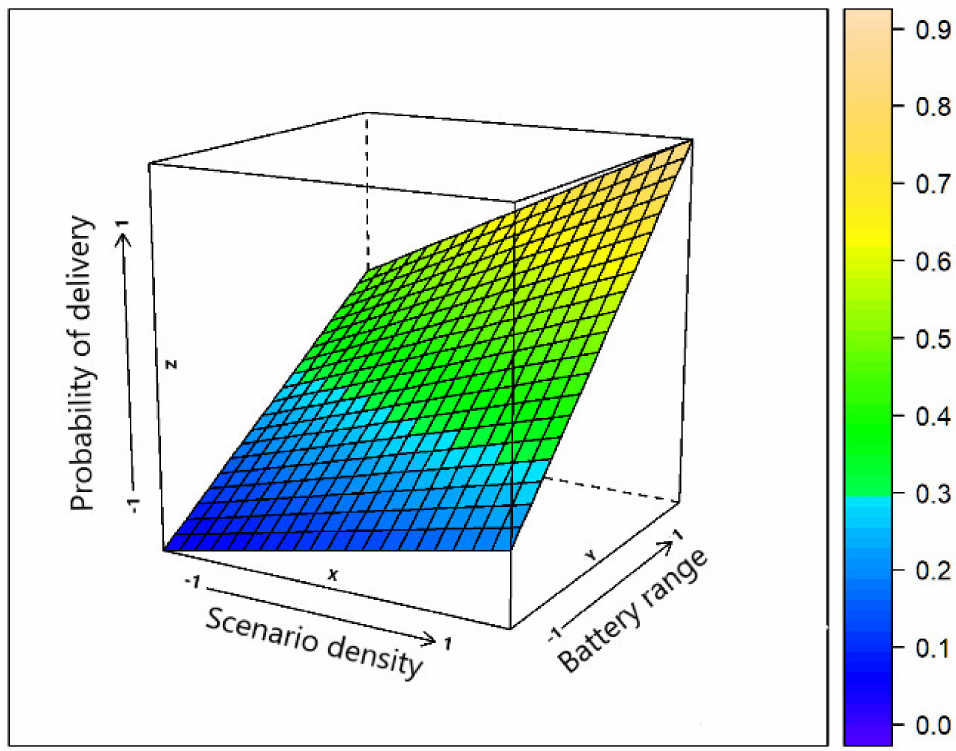
Figure 1. Impact of the scenario density and battery range on the delivery probability of